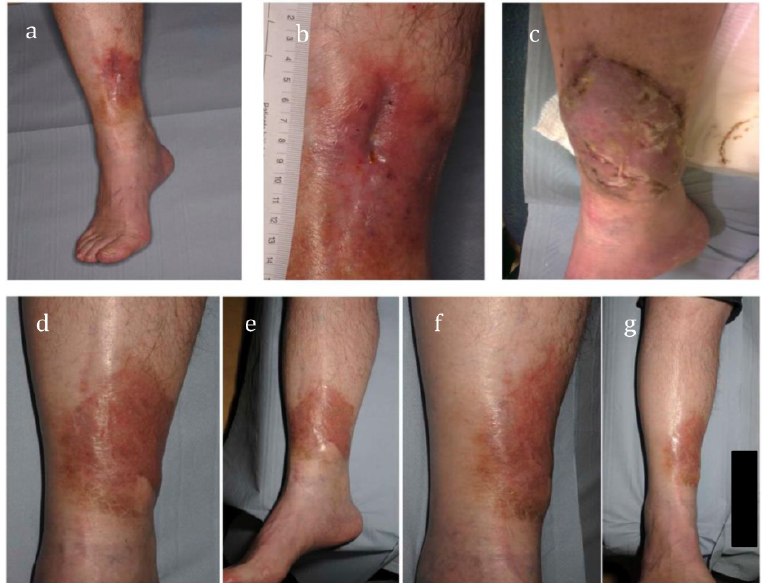
Figure 1 : A patient from the older cohort with C-M Stage III Bls osteomyelitis of the tibia with a sinus (a and b) , which had been present for over 14 months. Early post-operative photograph of free gracilis muscle flap and an unmeshed split-thickness skin graft (c). The final reconstructive outcome at 14 months post-op (d-g).